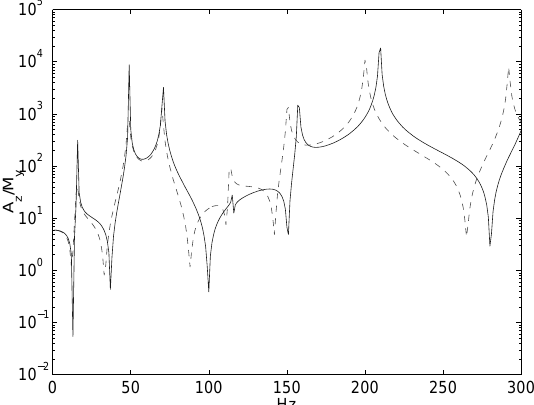
Fig. 4. SEREP expansion of translation/moment frame FRFs: theoretical FRF from FE model (–); SEREP expansion using 7 test points (- - -).